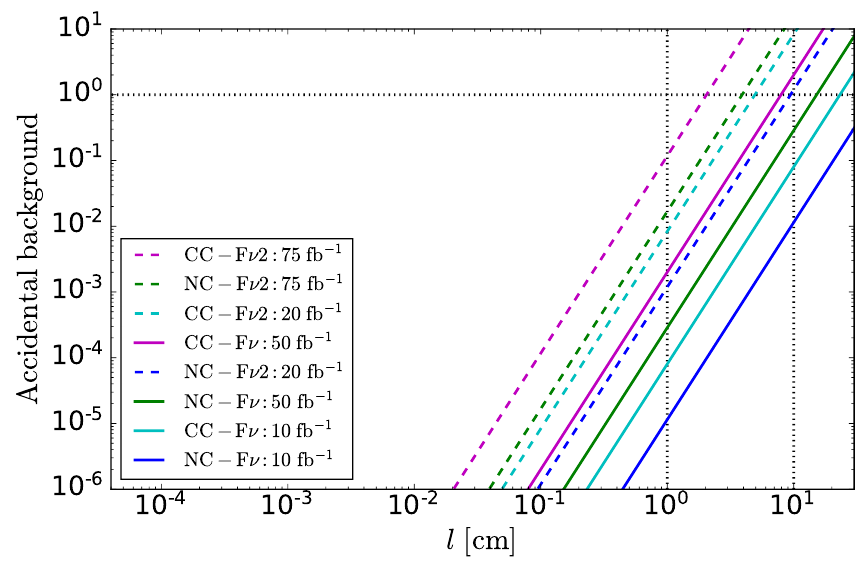
Figure 5 . Number of accidental backgrounds for the N → νq ¯ q and N → µq 0 ¯ q signals at FASER ν and FASER ν 2 for data taking periods with collected data of 10, 20, 50 and 75 fb − 1 . Background consists of a NC or CC vertex (respectively, marked as NC or CC) located within a narrow cone of opening angle of 10 − 2 and a height of l in front of another neutral current vertex with a topology and orientation as depicted in figure 4. The solid and dashed lines respectively correspond to FASER ν and FASER ν